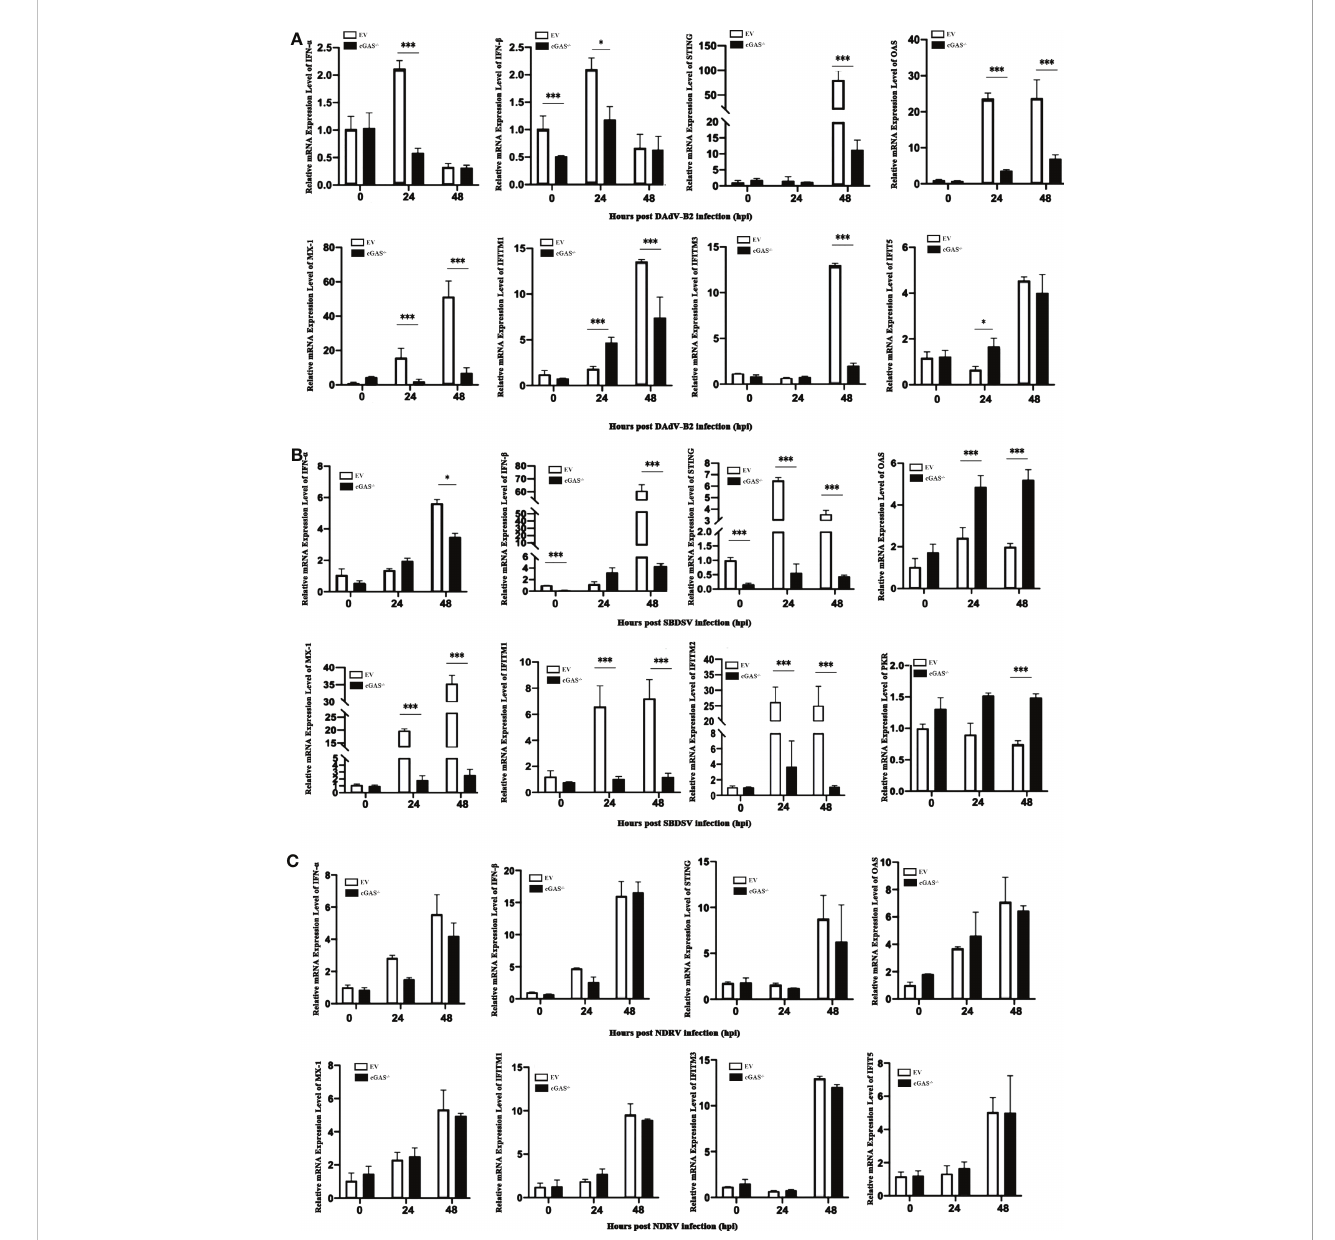
FIGURE 4 The expression levels of IFNs and ISGs in du-cGAS knockout DEFs after virus infection. Du-cGAS -/- and EV DEFs were infected with DAdV-B2, SBDSV, and NDRV at the MOI of 0.25 and harvested at 24 and 48 hpi respectively. The relative mRNA expression levels of type I IFNs, STING and key ISGs in virus-infected DEFs were analyzed via qRT-PCR. (A) DAdV-B2 infection. (B) SBDSV infection. (C) NDRV infection. Data represent the mean values ± SD, and statistical signi fi cance was analyzed by t-test. * P < 0.05, ** P < 0.01, *** P <